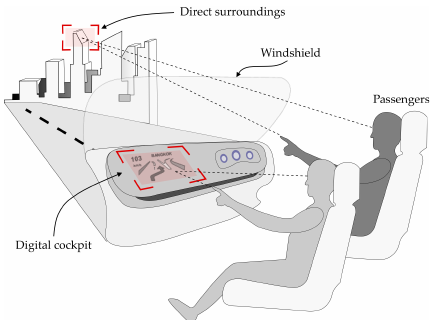
Figure 9. Scenario of a human-machine interface in a